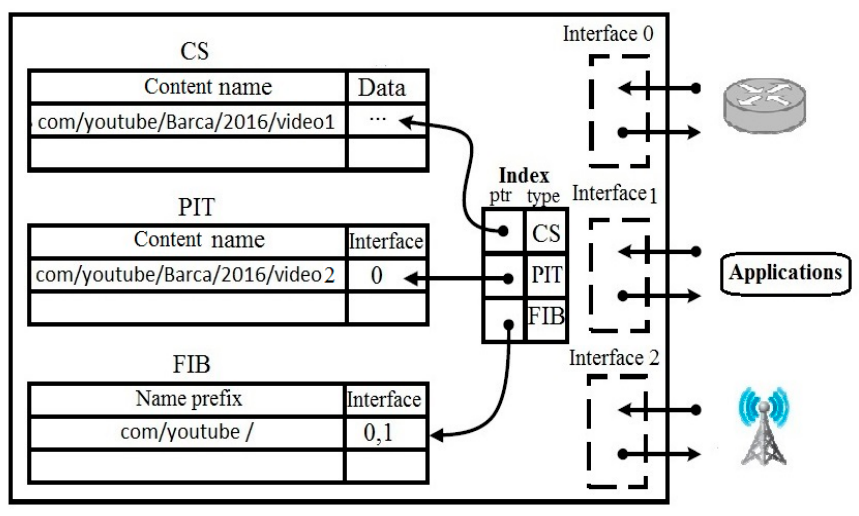
Figure1. NDN router and its components [1]. Figure 1. NDN router and its components [1].